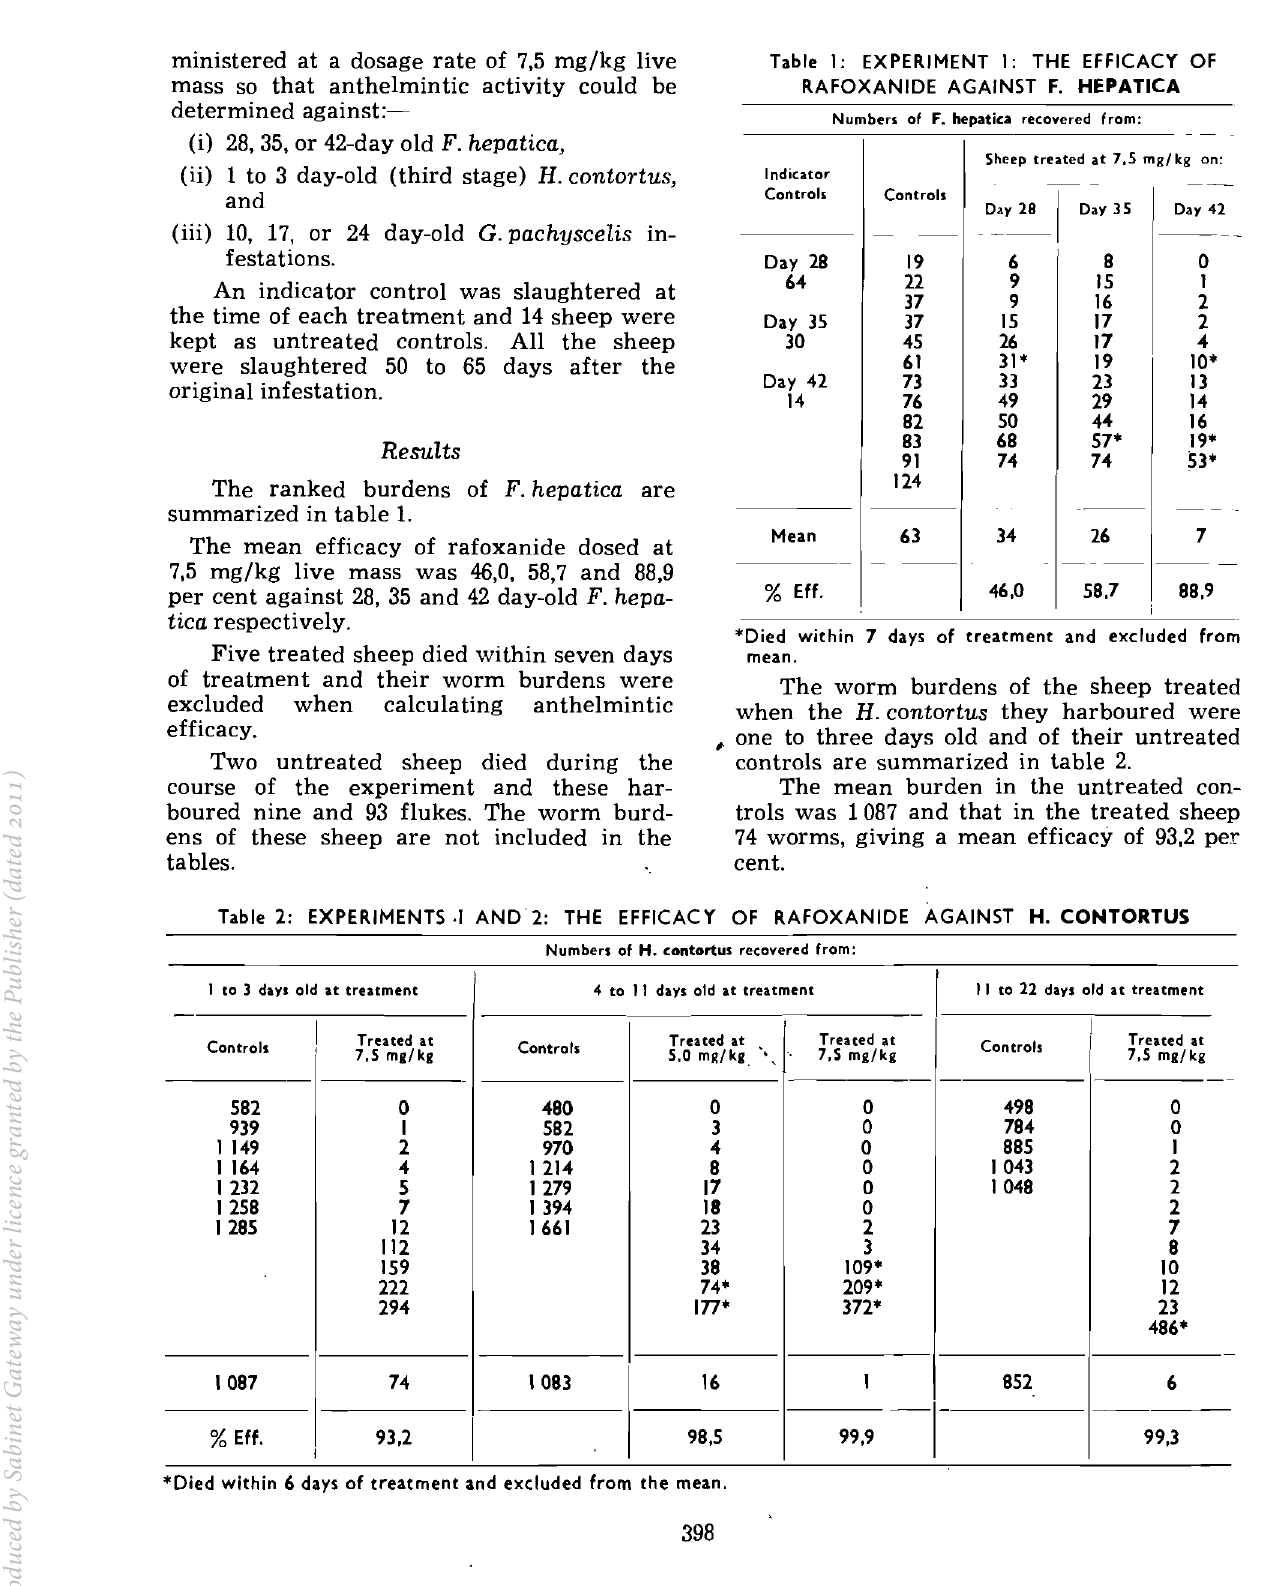
Table 1: EXPERIMENT I: THE EFFICACY OF RAFOXANIDE AGAINST F. HEPATICA Numbers of F. hepatica reco •• r.d from: Indicaeor Concrol.